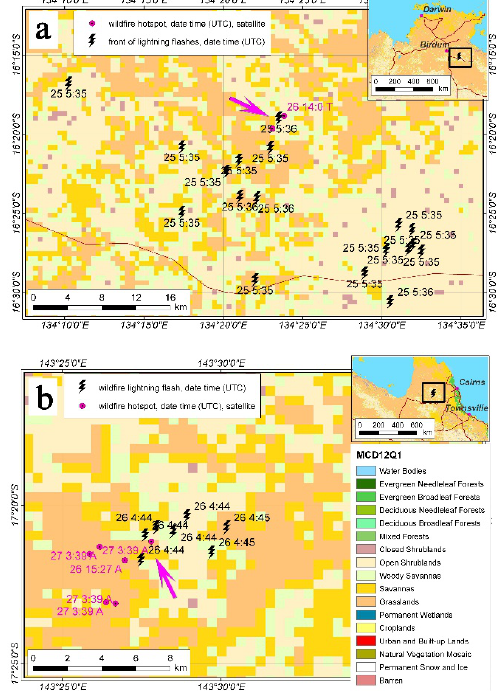
Other samples of multiple ignitions of lightning wildfires separated by a long dis- tance (30–80 km) are presented in Figure 13a,b. In particular, the two events of lightning Figure 12. The period of lightning wildfires on 25–26 December 2018 is presented for two study wildfire ignitions took place on 21 October 2019, in the northwest of Australia (Figure Figure 12. The period of lightning wildfires on 25–26 December 2018 is presented for two study cases, which took place in the north part of Australia, near Darwin ( a ) and Cairns ( b ). These Figures 13a). Further, three lightning wildfires, presented in Figure13b, correspond to events that cases, which took place in the north part of Australia, near Darwin ( a ) and Cairns ( b ). These Figures took place in the south of Australia on 29 December 2019. demonstrate that wildfires, triggered by the lightning storms, are allocated at the edge of thunderstorms. demonstrate that wildfires, triggered by the lightning storms, are allocated at the edge of thunder- storms.